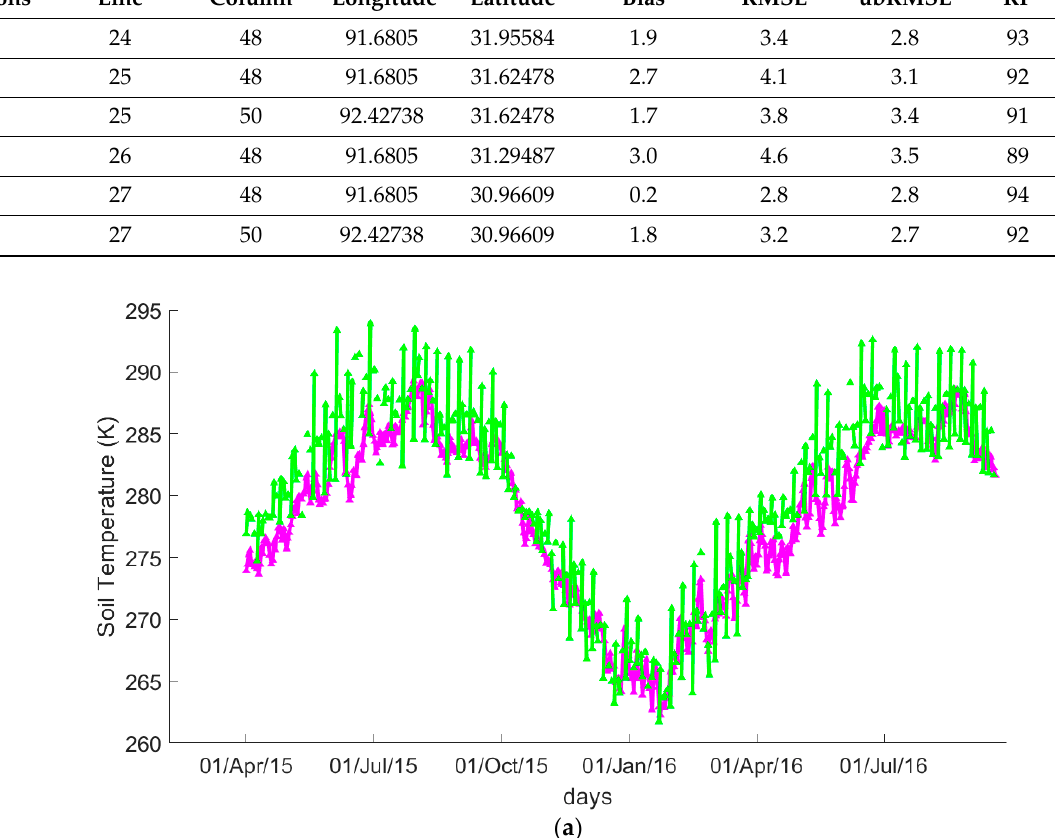
Table 2. Comparison between Satellite (SPL3SMP_36km) and observed surface temperature at the validation sites in Naqu based on the Tibetan Plateau, including all the datasets from 1 April 2015 to September 2016. Error metrics of different grids are listed below; units are in (K).